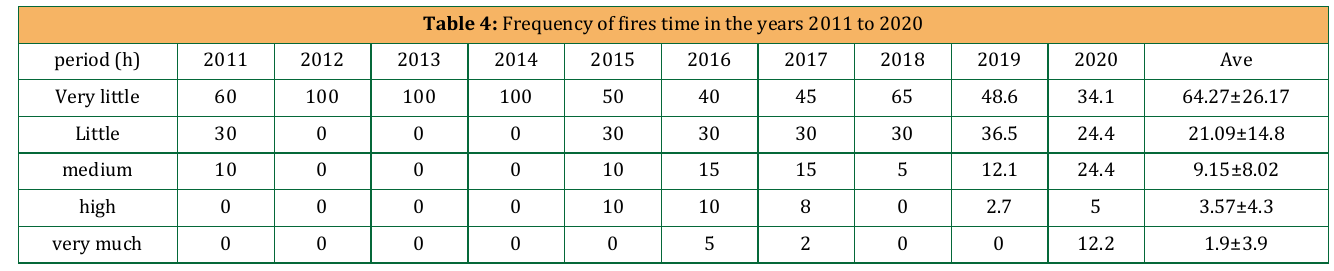
Table 4 : Frequency of fires time in the years 2011 to 2020